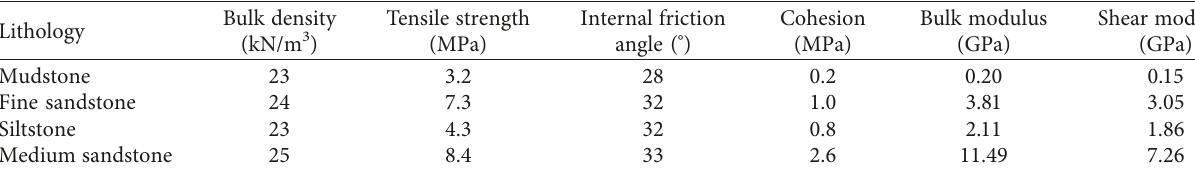
Table 1: Modeling parameters of each rock layer.